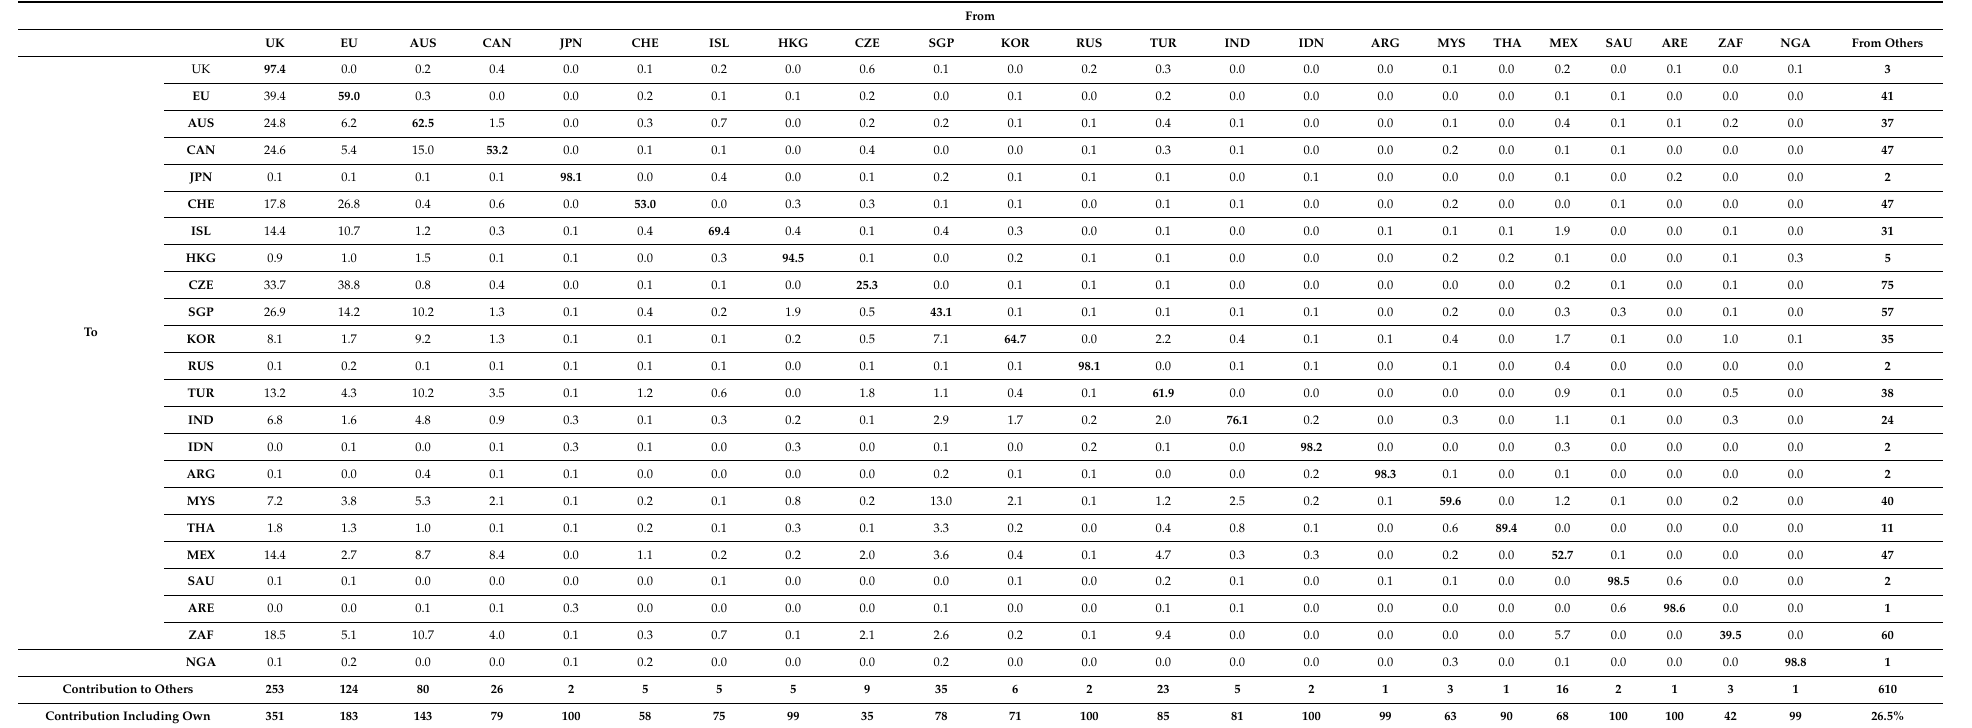
Table 4. Spillover table. Global foreign exchange (FX) market volatility, 31 May 2005–1 June